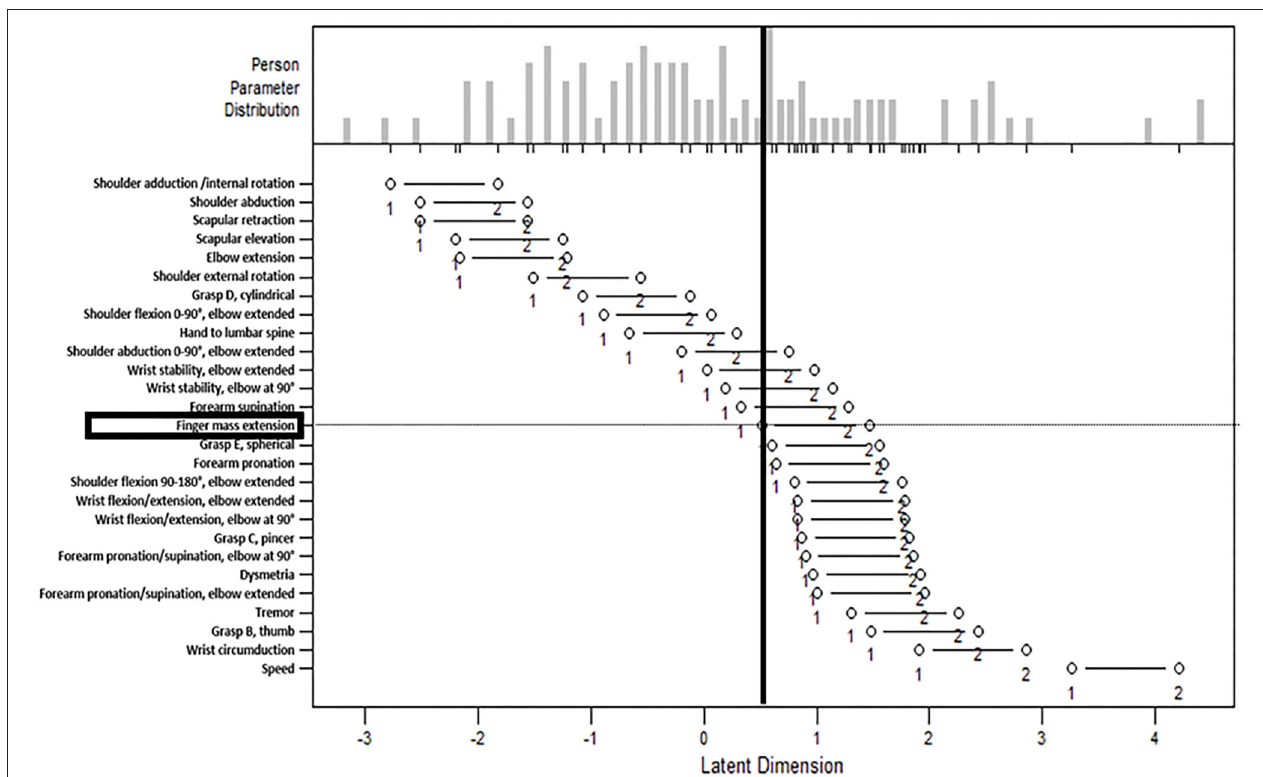
FIGURE 1 | The person-item map. The person-item map with the person’s ability plotted in the upper panel and the item difficulty plotted in the lower panel. The horizontal axis of the lower panel is a parameter of the item difficulty (calibrated with logits; values not normalized), with higher logits representing higher item difficulty. The horizontal axis of the upper panel is a parameter of the person’s ability using the same scale as the parameter of item difficulty in the lower panel. The left white dot depicts the item difficulty measures. Item scores are likely to be 0 if a participant’s ability is on the left side of the left white dot, 1 if a participant’s ability is between two white dots, and 2 if a participant’s ability is on the right side of the right white dot. The item “finger mass extension” is highlighted, and the vertical line divides the participants, which suggests that over half of the participants were incapable of extending their fingers.